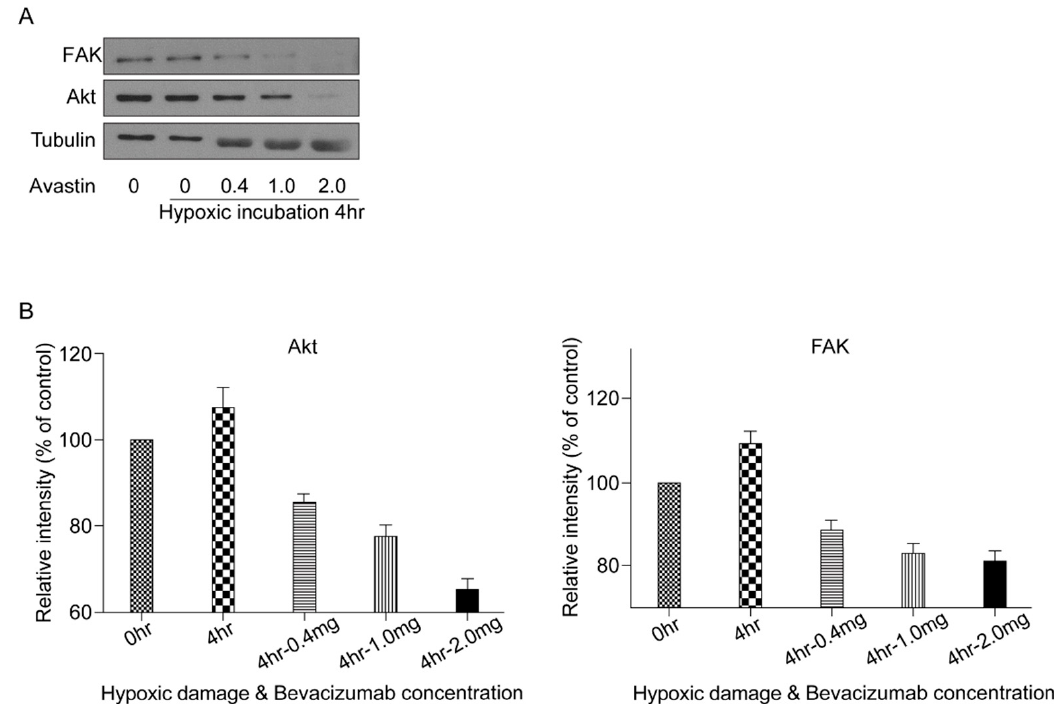
Figure 6. Hypoxic preconditioning and the vascular endothelial growth factor (VEGF) survival pathway. ( A ) Signaling molecules involved in pathways downstream of VEGF activation were investigated using immunoblot assays. Akt and focal adhesion kinase (FAK) levels were compared between the 4-h hypoxic preconditioning group and groups in which bevacizumab (0.4, 1.0, and 2.0 mg/mL) was administered. Representative gel images are shown. ( B ) Densitometry of Akt and FAK immunoblots. Data in the columns indicate the mean density ± SD, normalized to the level of tubulin in the same sample.